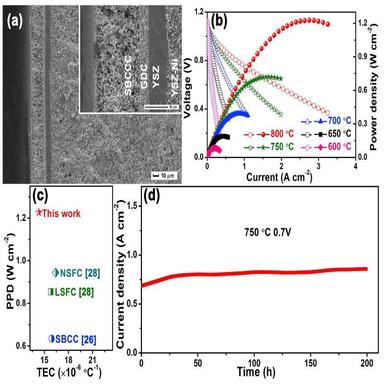
(a) SEM image of the SBCCC/GDC/YSZ/YSZ-Ni single-cell. (b) Current-voltage and current-power plots of the SBCCC-based single-cell. (c) The PPDs of the SBCCC-, SBCC-, LSFC-, and NSFC-based single-cells at 800 °C with the same cathode// GDC/YSZ/YSZ-Ni configuration and testing condition. (d) The output current densities of the SBCCCbased single-cell at 750 °C and 0.7 V.